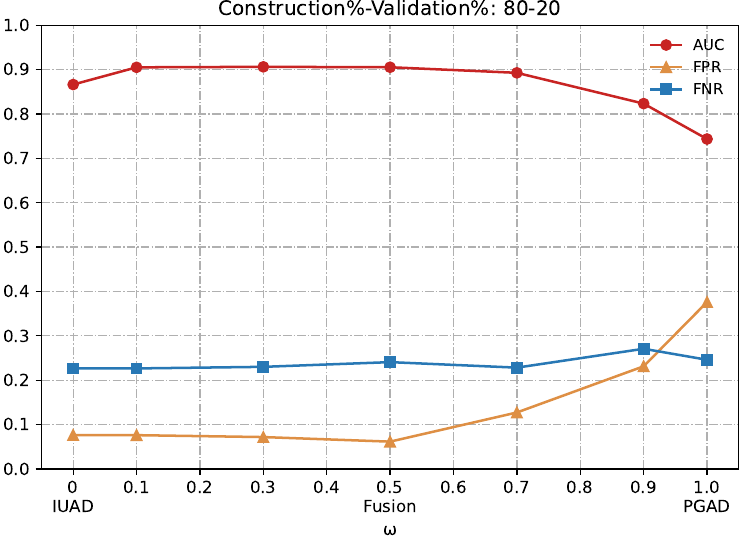
Figure 7. Detection results of the IUAD, the PGAD and the fusion model in terms of AUC, FPR, FNR (User’s http records division based on Construction%–Validation%: